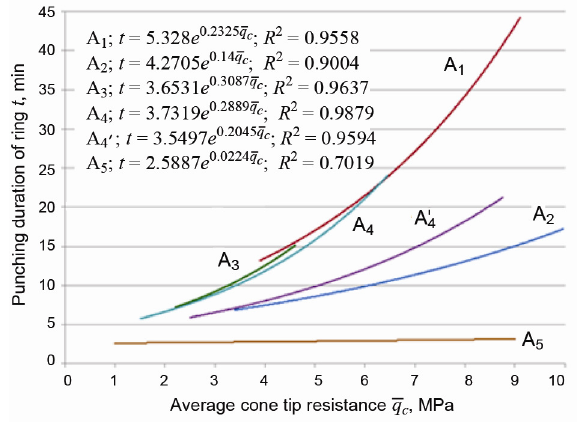
Fig. 7. Influence of soil conditions on the ring punching time, using the exponential dependence regression equation